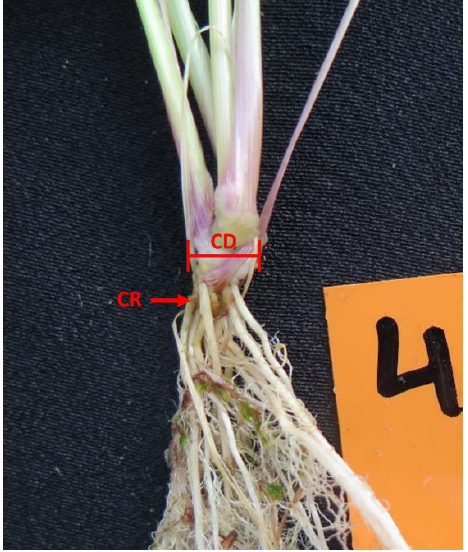
Figure 3. Typical root–shoot junction (crown) of tef, demonstrating the crown diameter measuring point and the crown roots used to record their number and diameter.